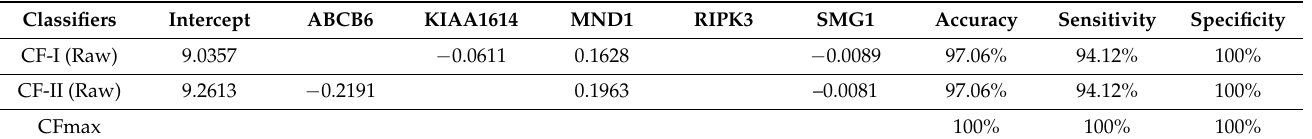
Table 2. Performance of individual classifiers and combined max-competing classifiers using blood- sample data GSE152418 to classify COVID-19-infected and healthy controls into their respective groups. The meaning of CF-i is the same as those in Table 1. Raw stands for raw